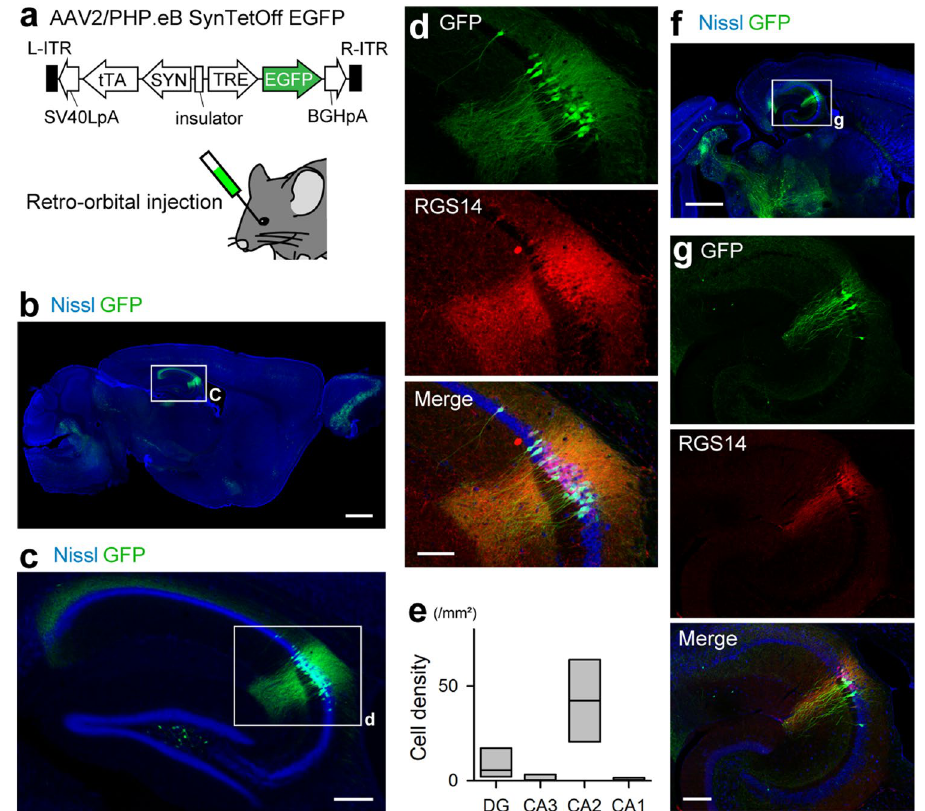
Figure 1. Preferential expression of GFP for CA2 pyramidal cells with AAV-PHP.eB capsid. ( a ) AAV2/ PHP.eB-SynTetOff-EGFP vector (top) and a schematic view of the retro-orbital injection (bottom). ( b ) GFP expression in a sagittal section after retro-orbital injection of the vector. Scale bar, 1 mm. ( c ) Enlarged view of the hippocampus in ( b ). Scale bar, 200 μm. ( d ) Enlarged view of the CA2 region in ( c ). Scale bar, 100 μm. ( e ) Distribution of GFP-expressing cells in the hippocampal subregions. The rectangles indicate the means and distributions of 25% and 75% ( n = 4 sections from 4 mice, H = 11.5, df = 3, P = 9.1 × 10 −3 , Kruskal–Wallis test). ( f ) Same as ( b ), but in a horizontal section at the level of the intermediate hippocampus. Scale bar, 1 mm. ( g ) Enlarged view of rectangle in ( f ). Scale bar, 200